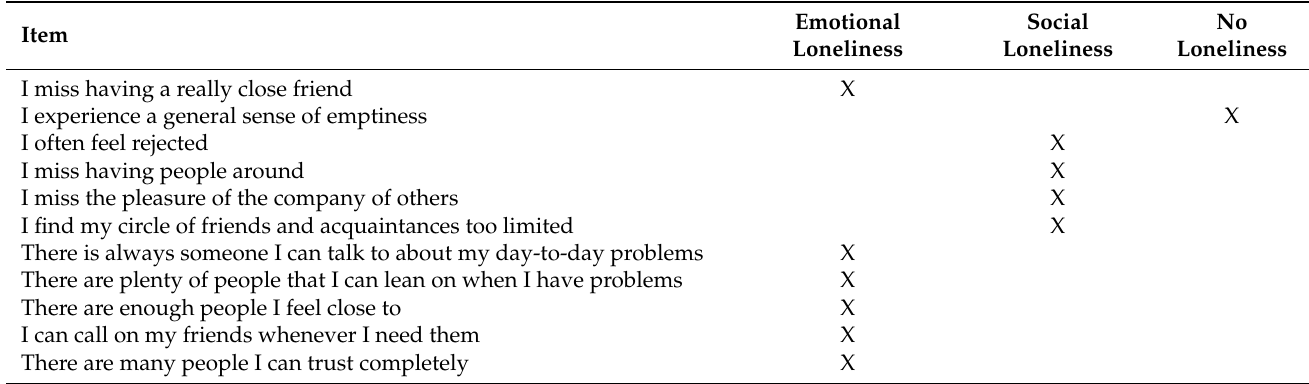
Table 3. Coding of Items of the Rasch-Type Loneliness Scale